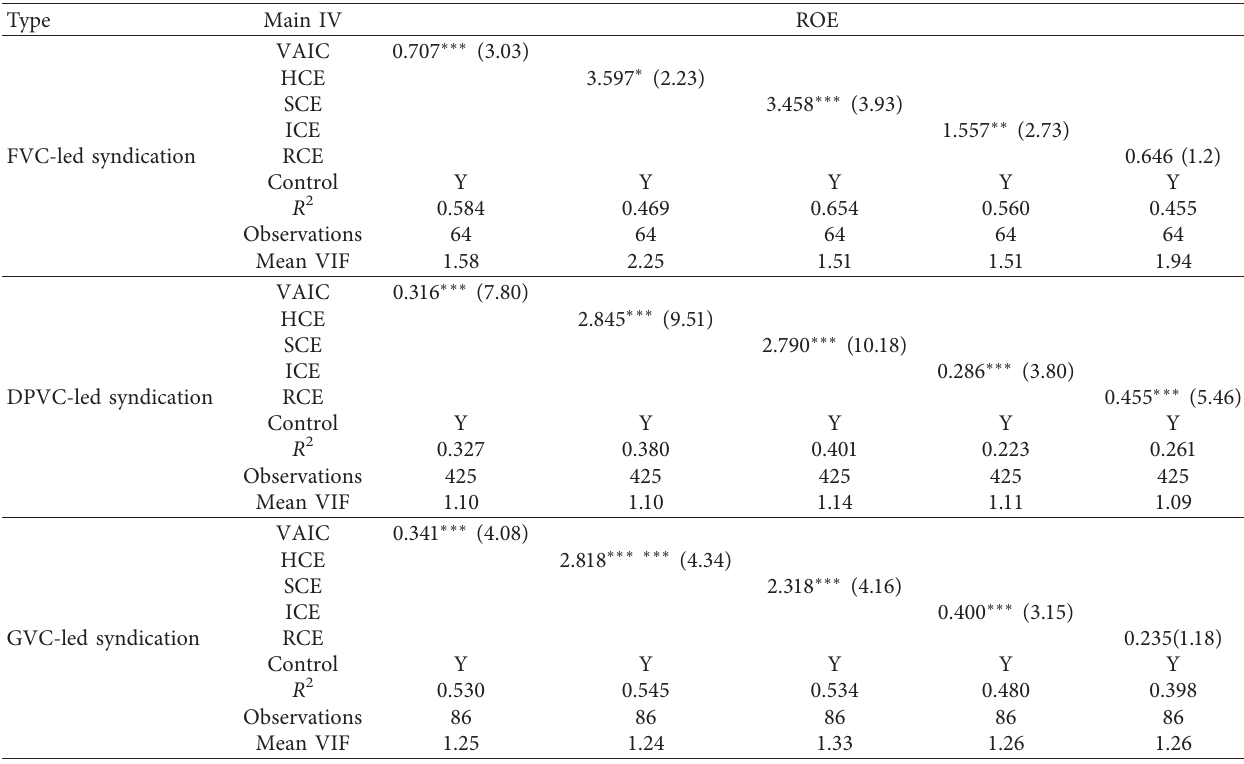
Table 10: Robustness check results of different VCS leading backgrounds.